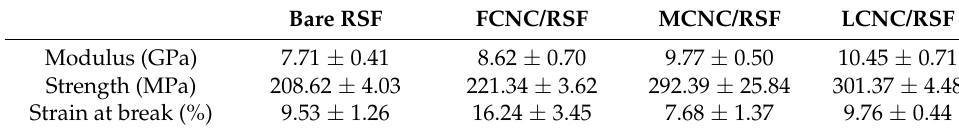
Figure 5. Influence of characteristics on mechanical strength of composites reinforced by three different CNCs. Different characteristics of CNC affects tensile modulus, strain at break, and tensile strength in different level. ( a ) Characteristic stress-strain curves, ( b ) Bar diagram of tensile modulus, ( c ) Bar diagram of strain at break, and ( d ) Bar diagram of tensile strength. Table 2. Mechanical properties of different CNC types in nanocomposite